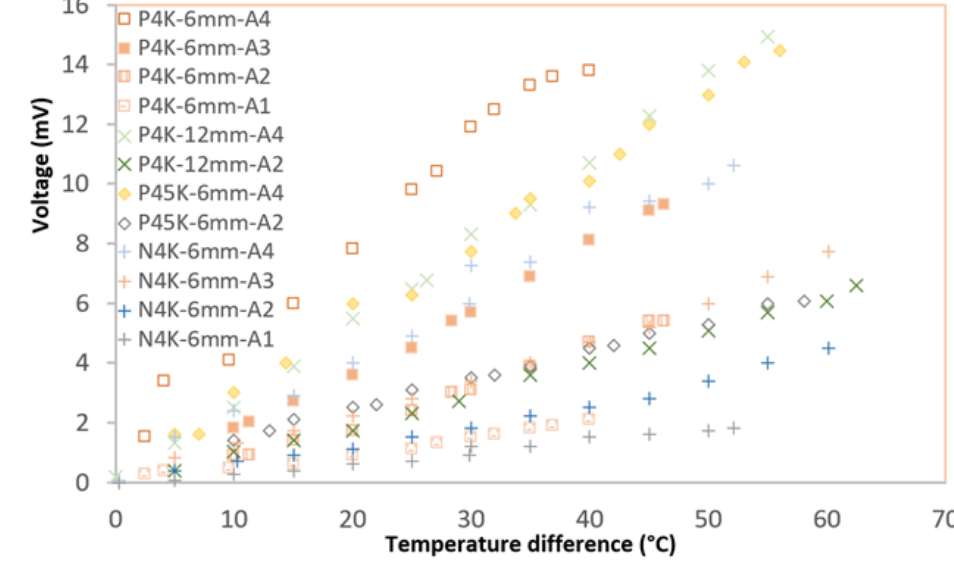
Figure 10. Open circuit voltage output of P-type layer with different widths (P4k-6 mm and P4k-12 mm) and thicknesses (P4k:2 µ m and P45k:2.5 µ m) on Kapton substrate.